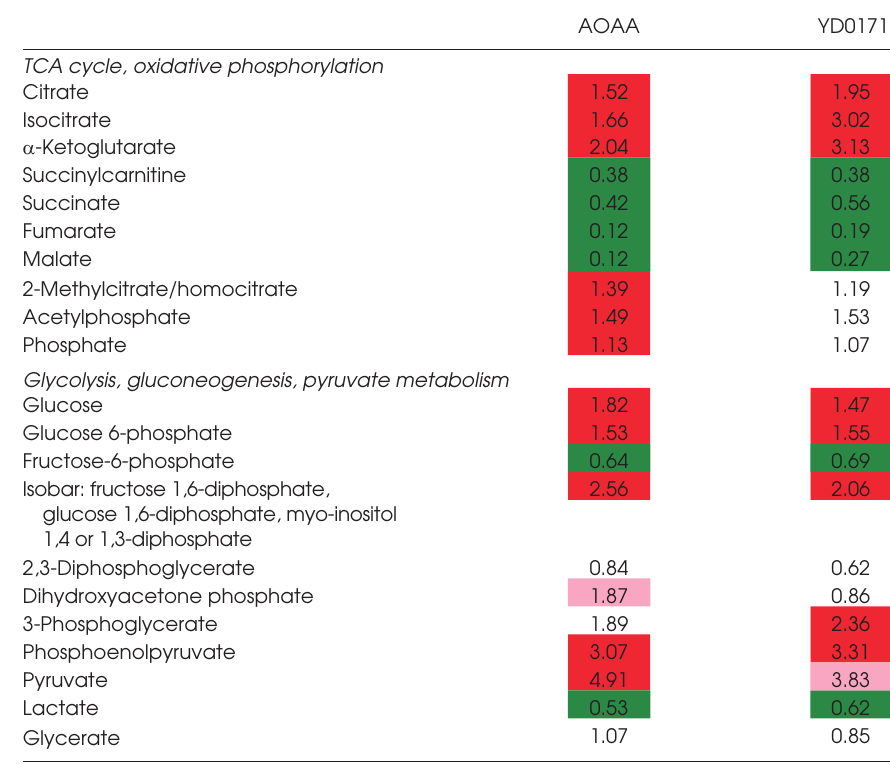
Table 2. Metabolomic effects: modulation of selected cellular energetics-related metabolites in HCT116 cells by YD0171 and AOAA treatment (1 mmol/L, 24 h). Numbers represent fold changes in metabolite concentrations; red background indicates an increase, green background indicates a decrease in the concentration of the metabolite over vehicle-treated